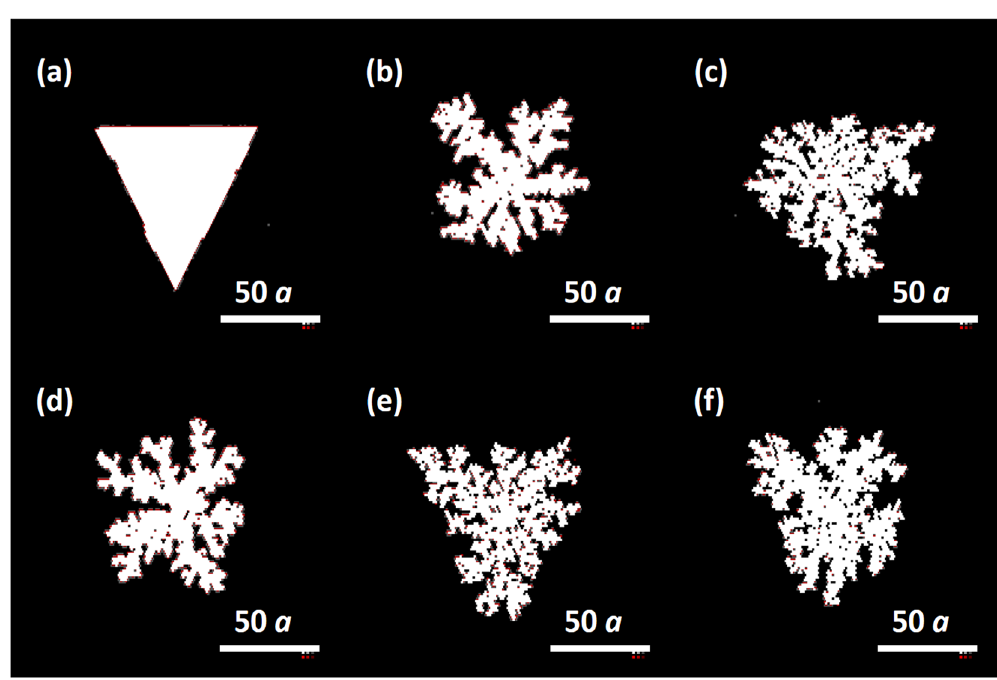
Figure 4. Domains’ morphology at different experimental conditions denoted in Fig. 3a. The scale bar is 50x lattice constant a . For WSe 2 , a = 332 pm, 50 a = 16.6